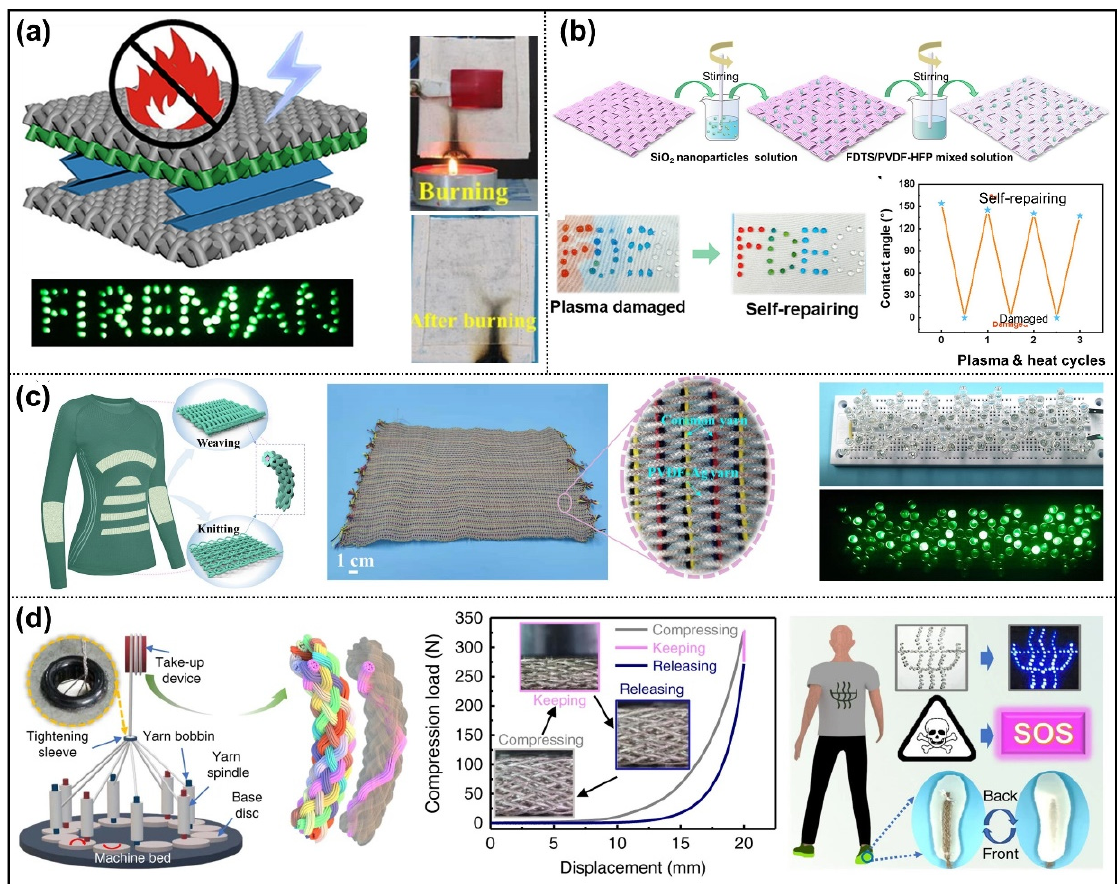
Figure 4. Fabric and yarn structured TENG. ( a ) A flame-retardant fabric coated with silver paste and PTFE as electrode and triboelectric layers. Reprinted with permission from Ref. [35]. Copyright 2020 American Chemical Society. ( b ) A kind of hydrophobic and self-cleaning fabric coated with fluorinated polymer and SiO 2 particles for water droplet energy harvesting. Reprinted with permission from Ref. [45]. Copyright 2021 American Chemical Society. ( c ) A large-scale core-shell type knitting triboelectric fiber by weaving PVDF yarns onto silver-coated nylon yarns. Reprinted with permission from Ref. [46]. Copyright 2022 Wiley. ( d ) A 3D braided intelligent self-powered and sensing fabric based on the shape adjustable structure with high compression rebound feature. Reprinted with permission from Ref. [48]. Copyright 2020 Nature.